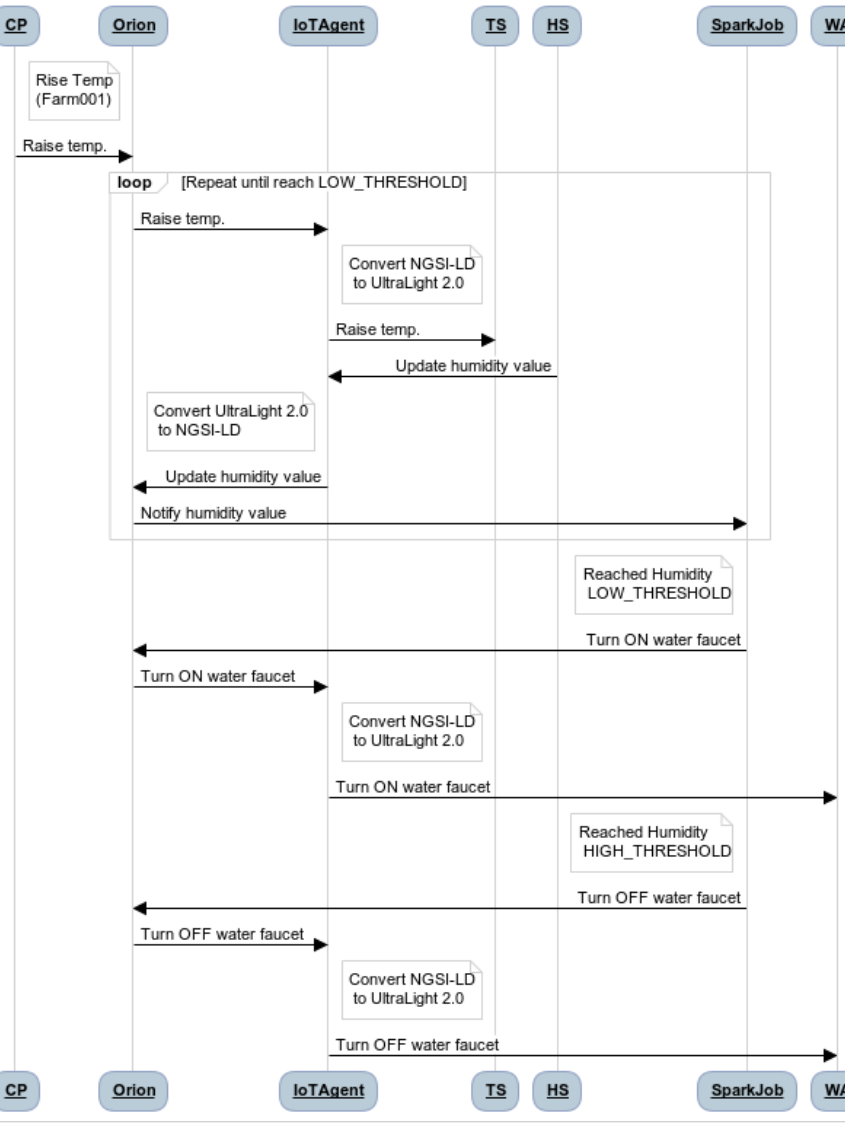
Figure 5. Smart farm scenario